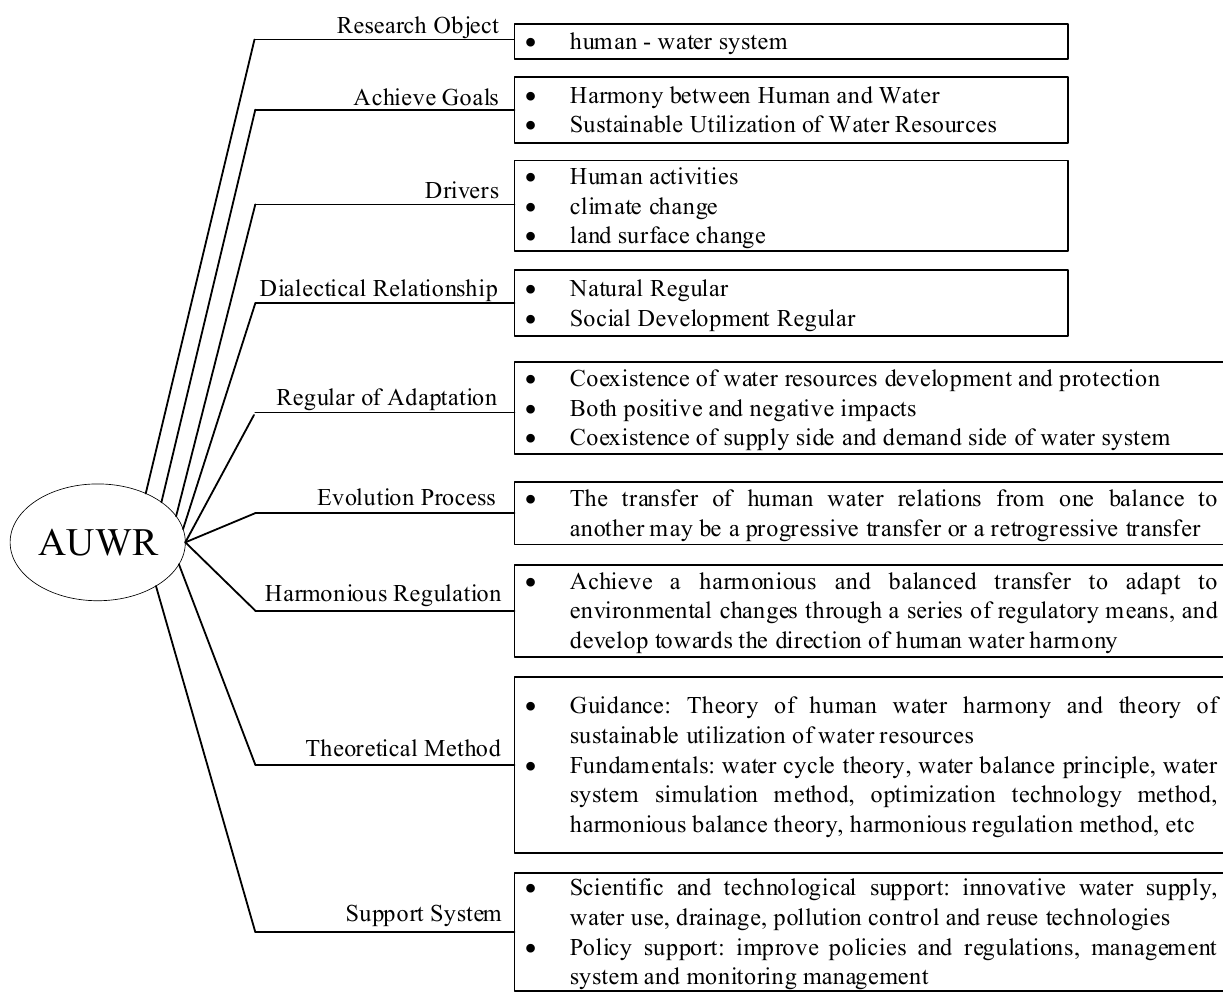
Figure 1. Framework of the theoretical system of AUWR.